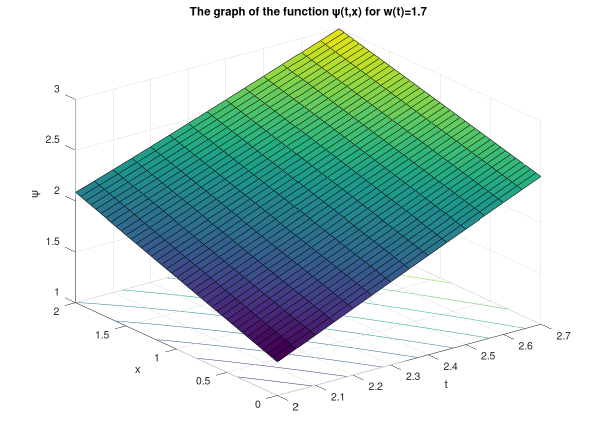
Figure 2. The graph of the function ψ for w ( t ) = 1.7 on I 1 = ( 2, e ]